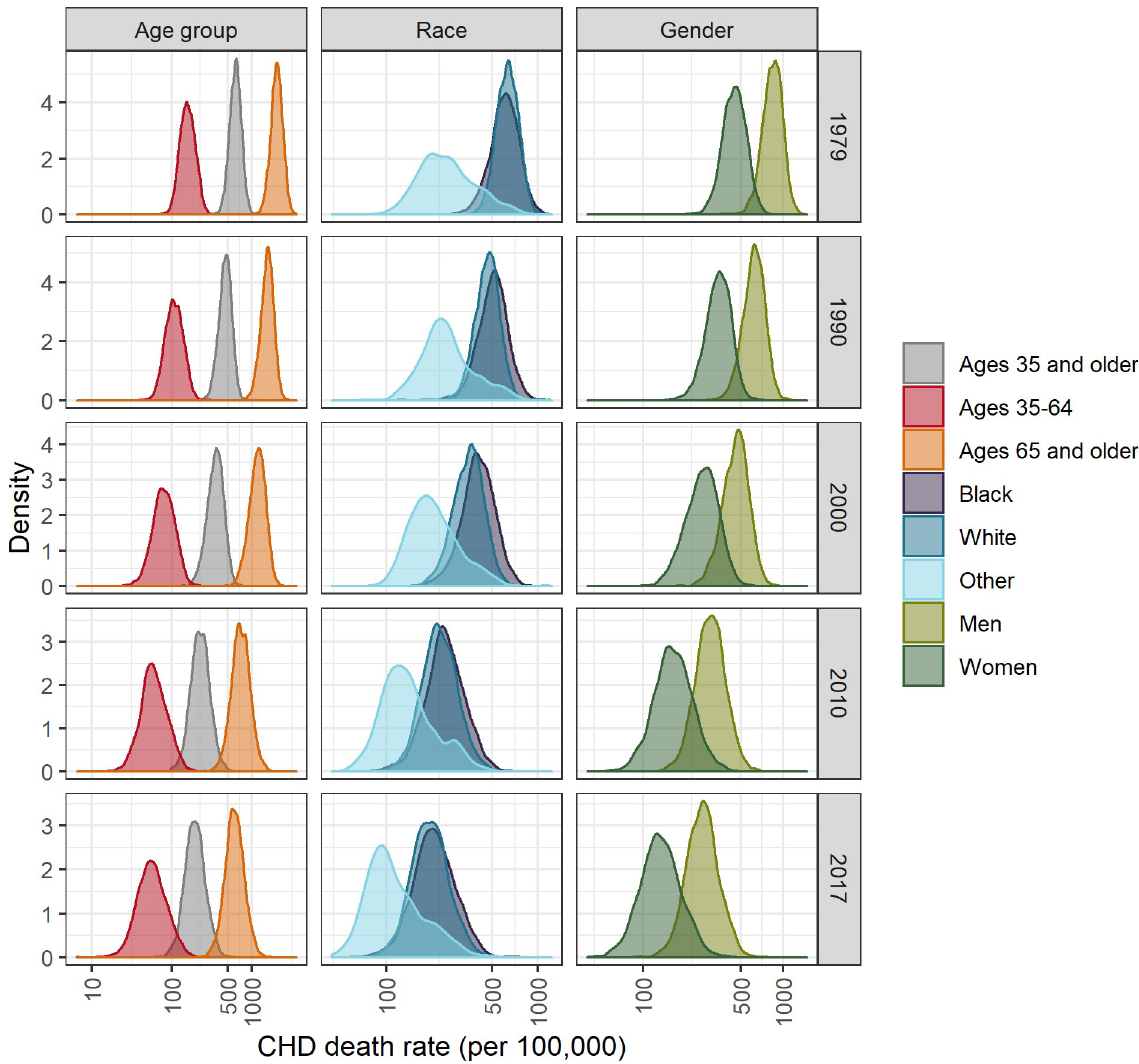
Fig 1. Distributions of county-level CHD death rates by year, age group, race, and gender, United States, 1979–2017. Race and gender groups are ages 35 and older.